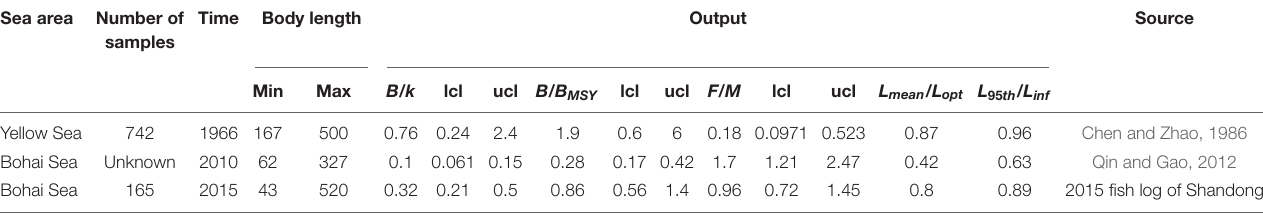
TABLE 1 | Main outputs of length-based Bayesian biomass (LBB) model for different periods. Sea area Number of Time Body length samples